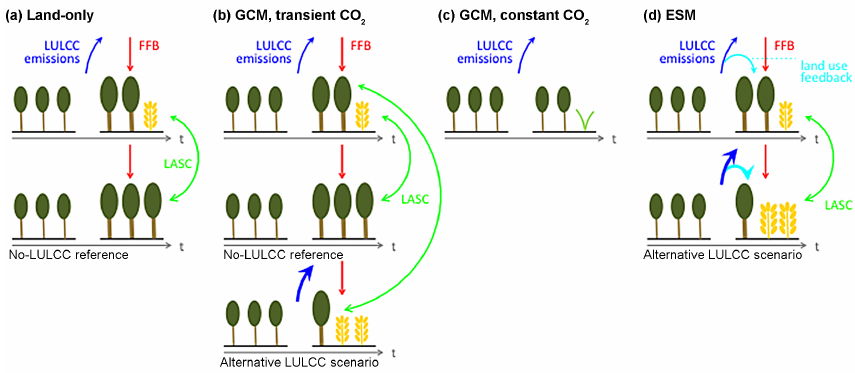
Figure 7. Illustration of the different setups used in the LUMIP experiments, using the example of forest replacement by cropland or grassland. The loss of additional sink capacity (LASC) is a factor when environmental conditions change transiently, which is the case when historical CO 2 concentrations, which implicitly include increases in CO 2 due to fossil-fuel burning (FFB) and LULCC, are prescribed from observations. Prognostic LULCC emissions are directly “seen” by the terrestrial vegetation (natural and anthropogenic) only in the ESM setup, where CO 2 is interactive. In this case, a fraction of the LULCC emissions is taken up again by the vegetation (“land-use carbon feedback”). Note that only atmospheric CO 2 is prescribed in (a – c) , while other environmental conditions feed back with LULCC’s biogeophysical